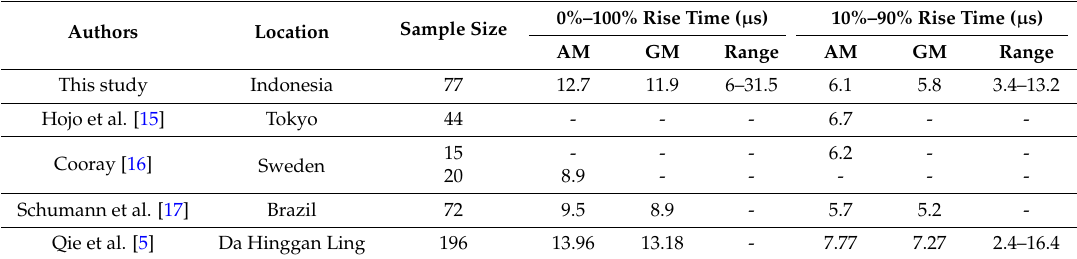
Table 1. Summary of rise time of return stroke waveform characteristics. AM, arithmetic mean; GM, geometric mean.